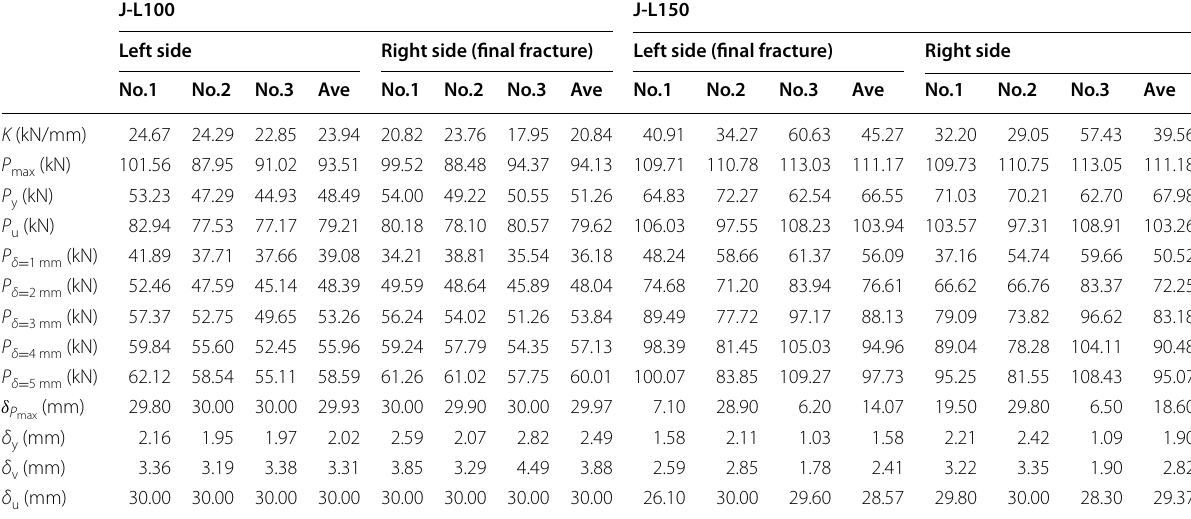
K : elastic stiffness, P max : maximum shear strength, P y : yield shear strength, P u : ultimate shear strength, P δ shear strength at a displacement of 2 mm, P δ strength at a displacement of 5 mm, δ P max : displacement at the maximum shear strength, δ y : yield displacement, δ v : P u / K , and δ u : ultimate displacement